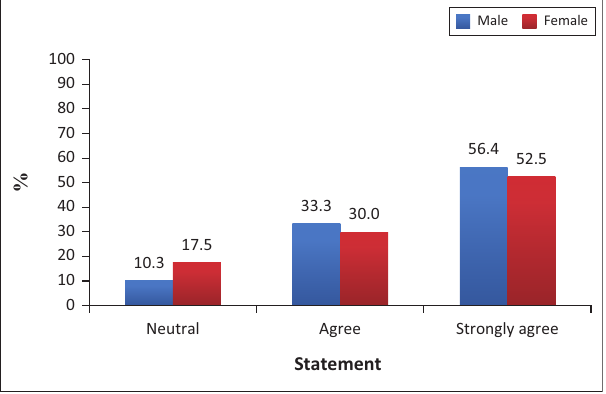
FIGURE 4: Drought impact on agriculture: Absence of soil